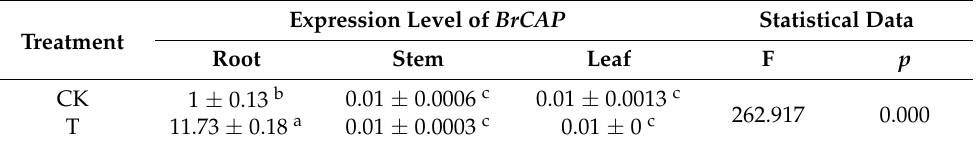
Table 3. Statistical analysis of the expression level of BrCAP among roots, stems, and leaves.